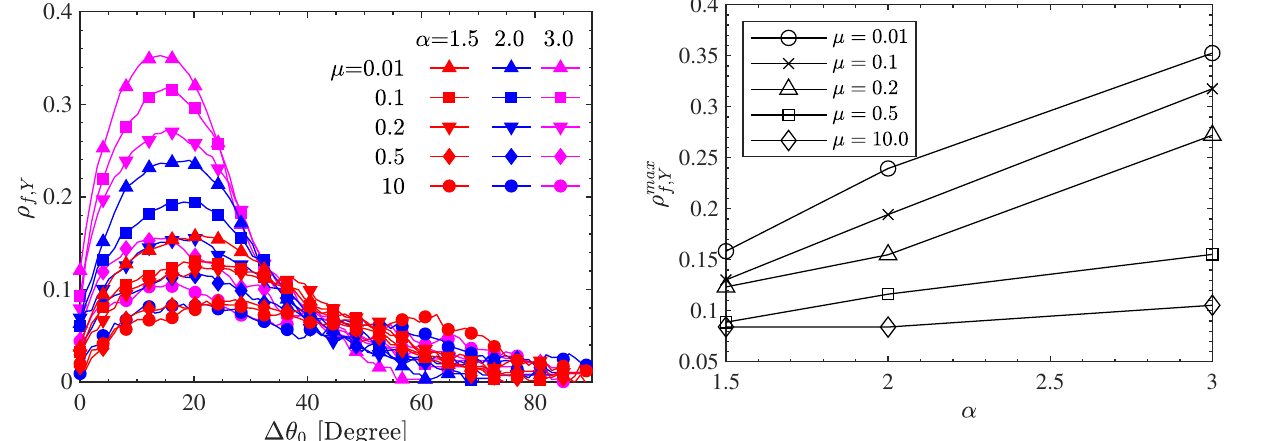
Figure 2. The correlation coe ffi cient ρ f , Y ( ∆ θ 0 ) for various aspect ratios α and intergranular friction coe ffi cients µ .